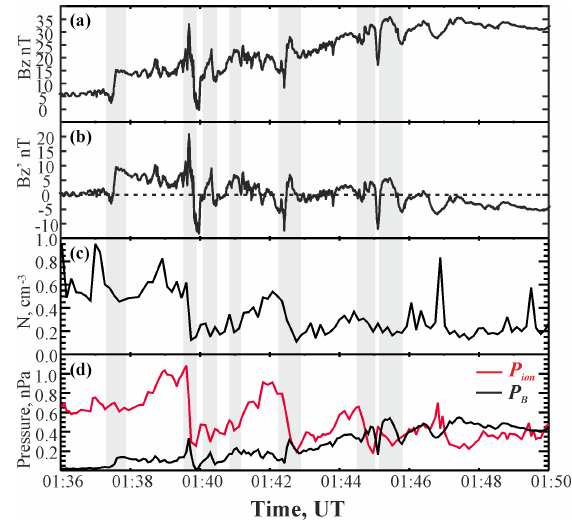
Figure 2. A zoom of the B Z (a) and B ∗ (c) , ion ( P ion ) and magnetic ( P B ) pressure (d) observed by C4 dur- ing the dipolarization growth. The intervals of strong B Z pulses are shaded